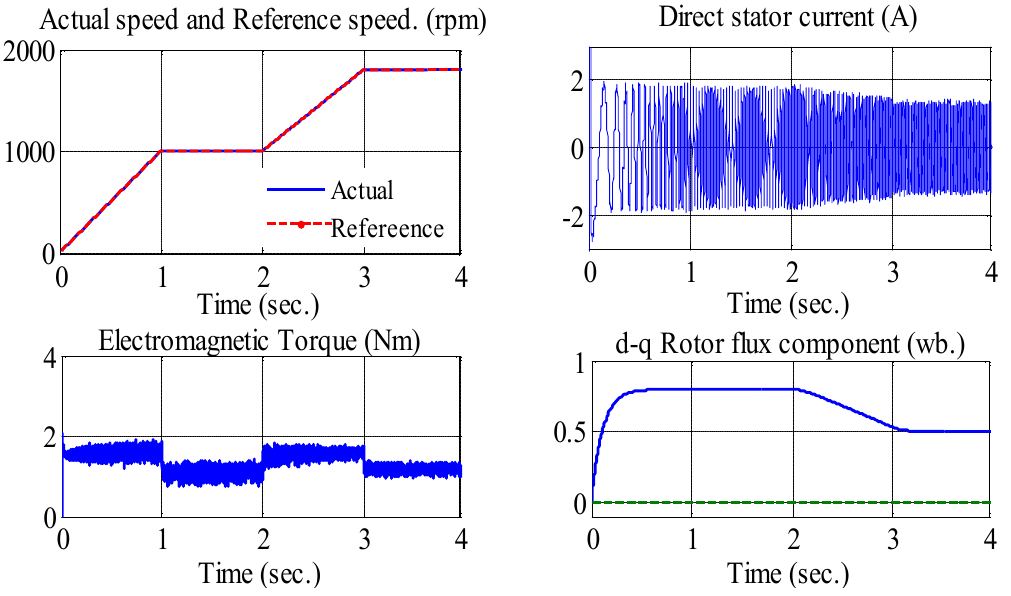
Figure 10. Performance of IFOC IM drive under field-weakening operation.